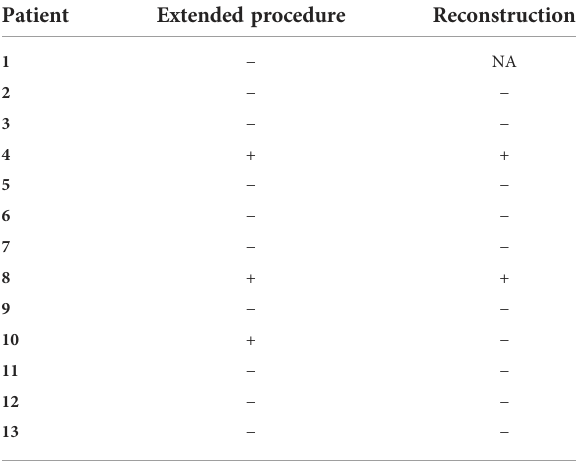
TABLE 3 Surgical approach and reconstruction data.